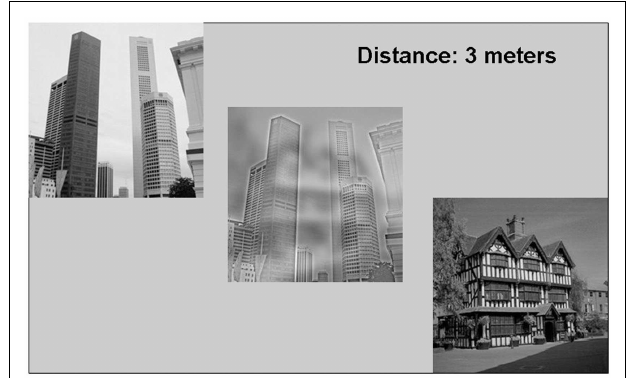
FIGURE 3 | Example display from Experiment 3. The images on the left and right of the display are the images composing the hybrid image located in the center of the display. Observers’ task was to stand at the distance indicated and report whether the hybrid looked more like the image on the left or the image on the